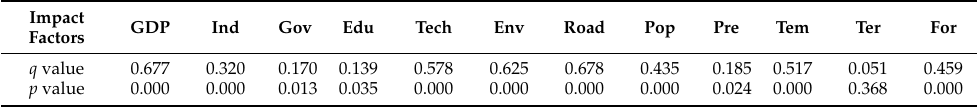
Table 6. Geographical detector detection results.